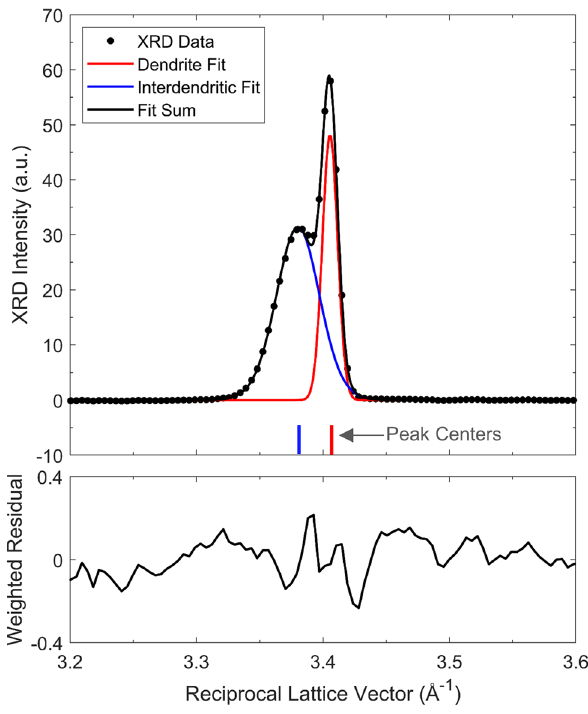
Figure 5. Example of a (200) XRD frame fit using two separate Pearson VII functions. The centers of the fitted peaks were used to calculate the FCC lattice parameters of the dendritic and interdendritic compositions,